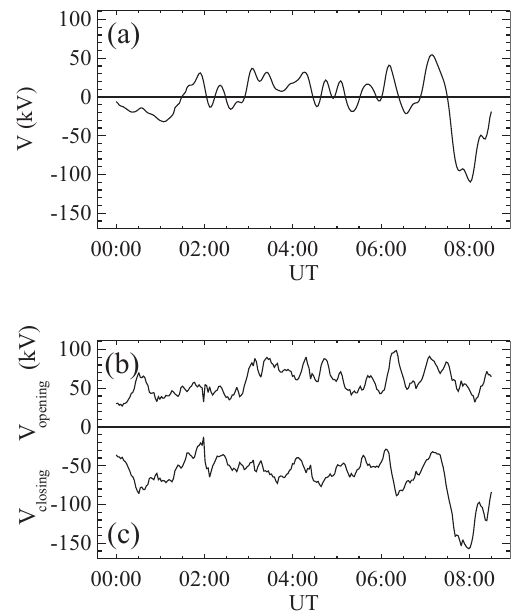
Figure 12. (a) Net reconnection voltage, (b) magnetic flux open- ing rate and (c) magnetic flux closure rate deduced from SI12 and SuperDARN observations on 26 January 2001. The values in panel (a) are the sum of those of panels (b) and (c)